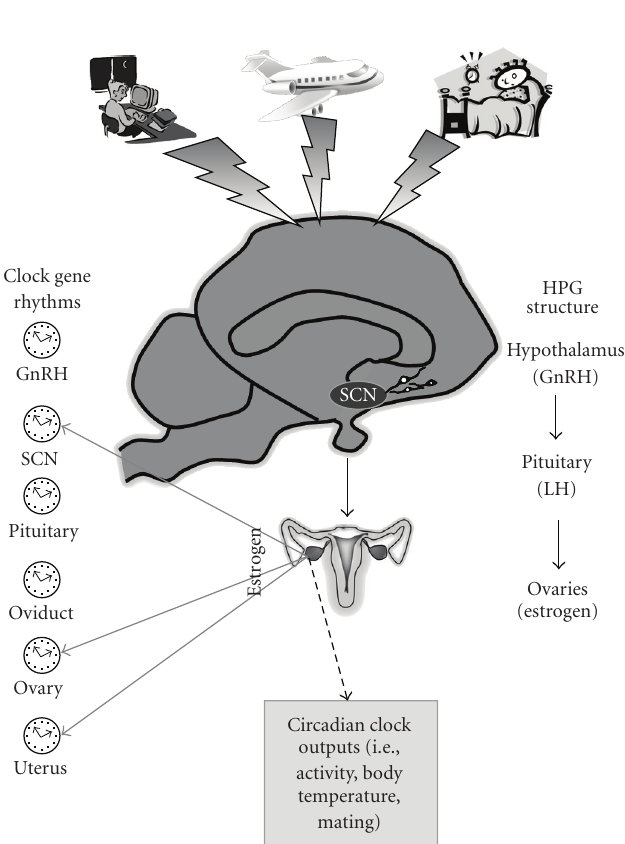
Figure 1: The hypothalamus-pituitary-gonadal axis regulates reproductive cycles in female mammals. Increasing levels of estrogens released from the ovaries feedback onto the hypothalamus. When estrogen stimulation reaches a threshold, gonadotropin releasing hormone (GnRH) neurons release their product into the blood stream. GnRH acts on the pituitary to trigger a surge of luteinizing hormone (LH) which then induces ovulation. In rodents, the suprachiasmatic nucleus (SCN) of the hypothalamus provides an additional signal which regulates the timing of reproductive events. Shift work schedules, jet lag, and sleep deprivation can perturb the daily (circadian) rhythms in reproduction and “clock gene” expression. Clock gene expression has been detected in the SCN, GnRH neurons and female reproductive tissues. Estrogen can influence the pattern of expression of gene expression in some of these tissues (solid arrows). Estrogen also influences the rhythmic expression of clock-controlled outputs such as activity and body temperature (dashed